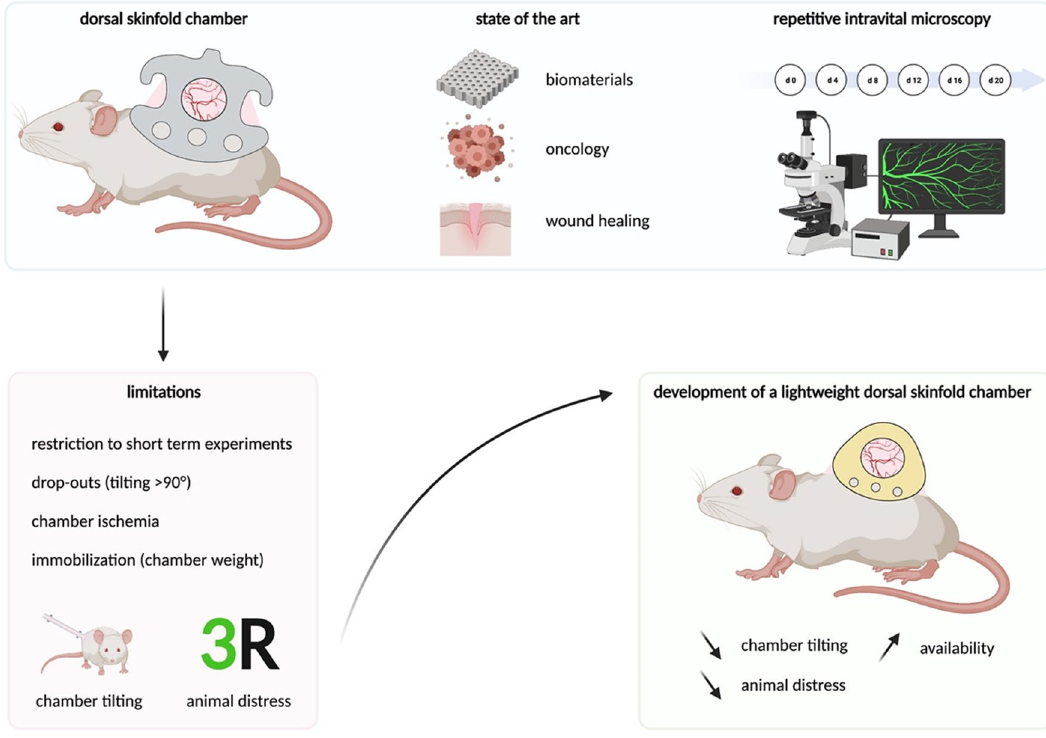
Figure 1. Application and limitations of the dorsal skinfold chamber. The model enables continuous observation of microvascular parameters by intravital microscopy. The major limitations are animal distress and restriction to short-term experiments. To improve animal welfare and extend the observation time, a lightweight, 3D-printable PEEK chamber was developed. Figure created with